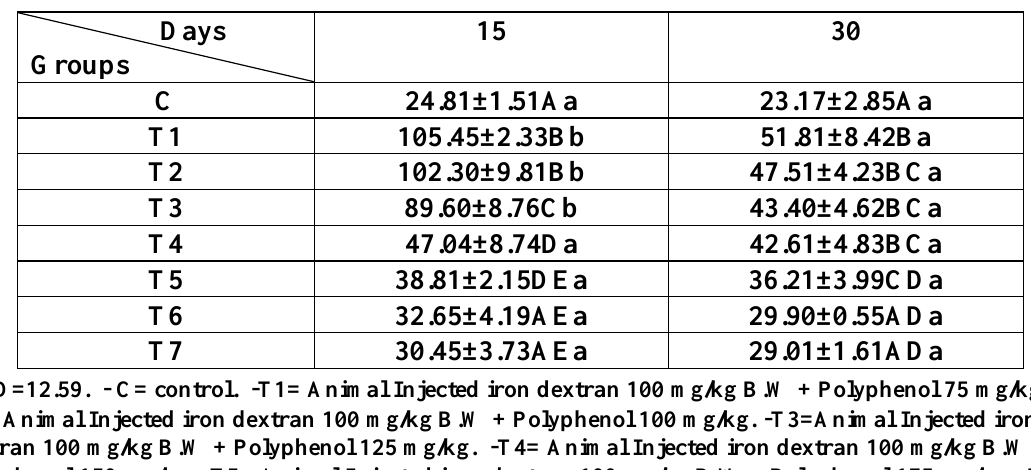
Table 5: Effect of different doses of total polyphenol Extracted from Green tea on Serum Peroxy nitrate radical Concentration (M/L) of iron overload treated